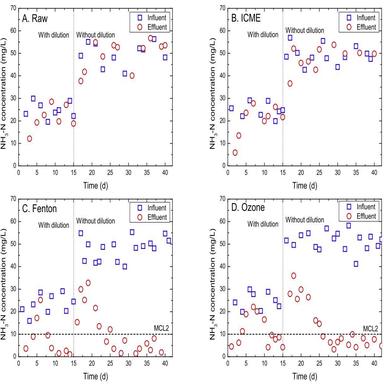
Effect of different pretreatment methods on NH3-N degradation in SBR.